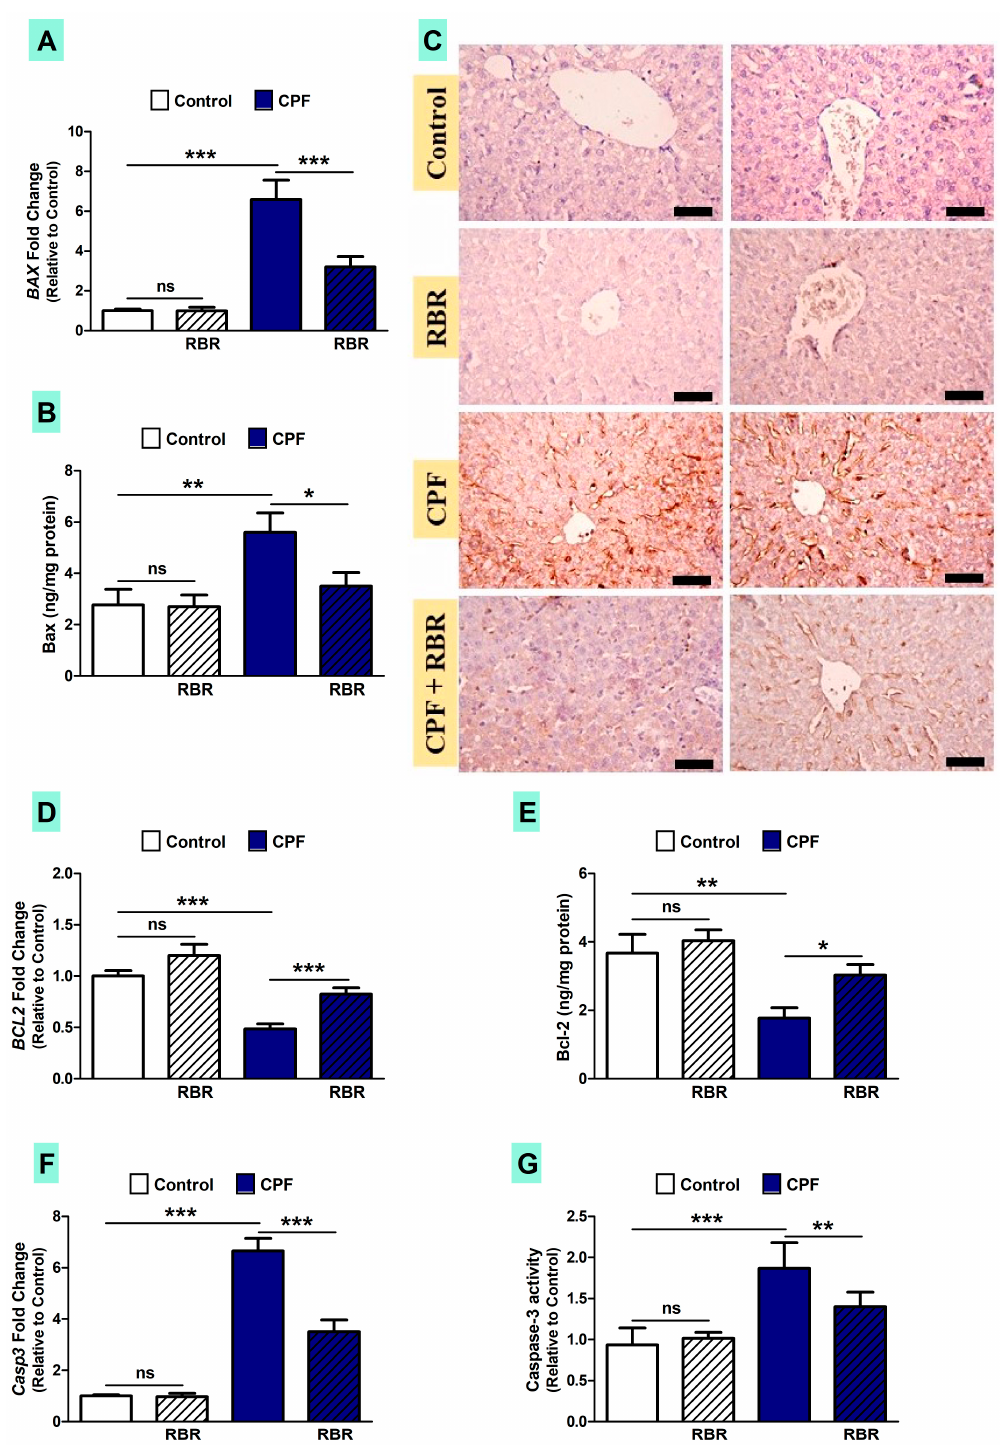
Figure 8. RBR mitigates apoptosis in CPF-induced rats. RBR decreases Bax mRNA ( A ) and protein ( B ) and caspase-3 ( F and G ). ( C ) Photomicrographs of the immunohistochemical staining of Bax showing increased Bax in the liver of CPF-intoxicated rats and the alleviative effect of RBR. (400×, Scale bar 50 µ m). ( D and E ) RBR increased Bcl-2 in CPF-intoxicated rats. Data are mean ± SD, (N = 7). * p < 0.05, ** p < 0.01 and *** p < 0.001. ns = non-significant.